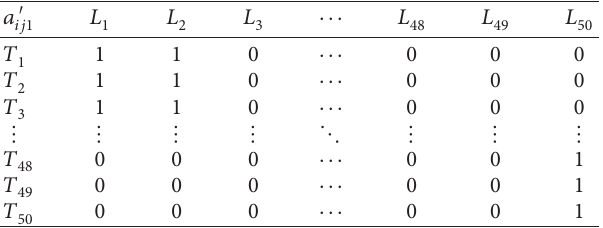
Table 14: Perceived utility matrix V s ′ � [ a ij ′ ] for 1 1 50 × 50 housing location.